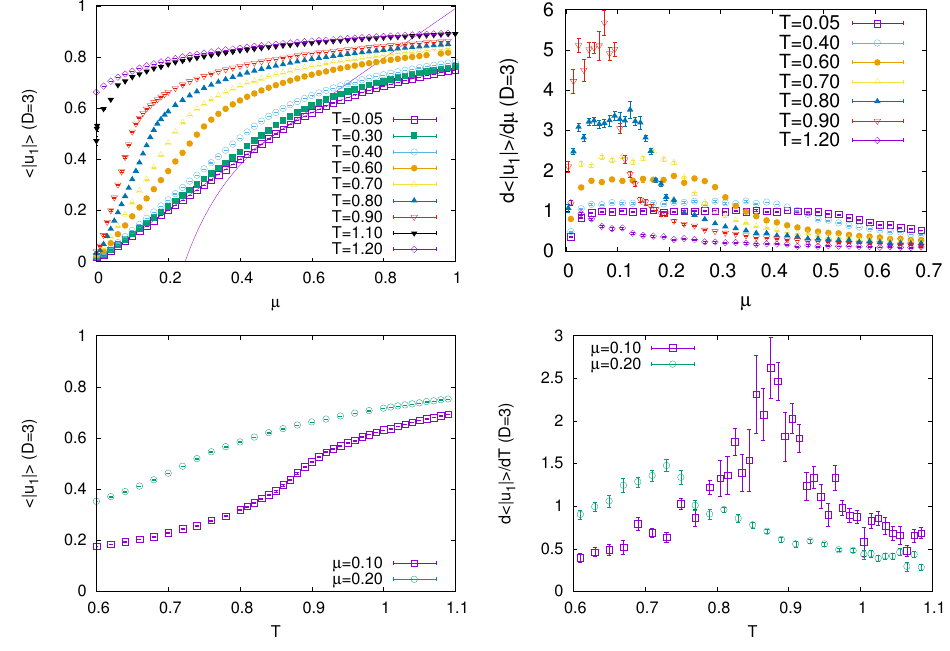
Figure 2 . hj u 1 ji (left) and d hj u 1 ji